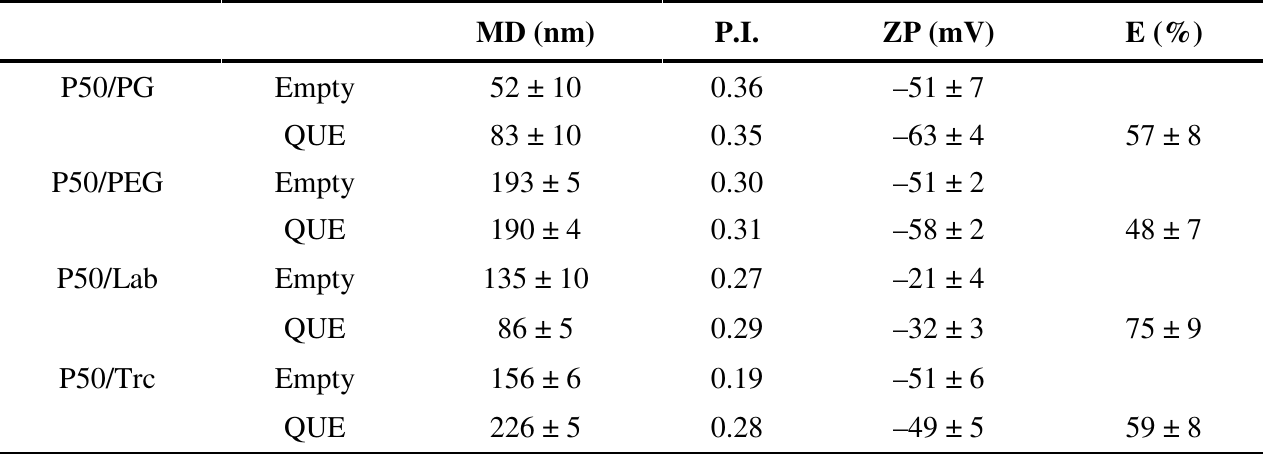
Table 1. Characteristics of empty and QUE-loaded PEVs: mean diameter (MD), polydispersity index (P.I.), zeta potential (ZP) and incorporation efficiency (E%). Each value represents the mean ± S.D., n =